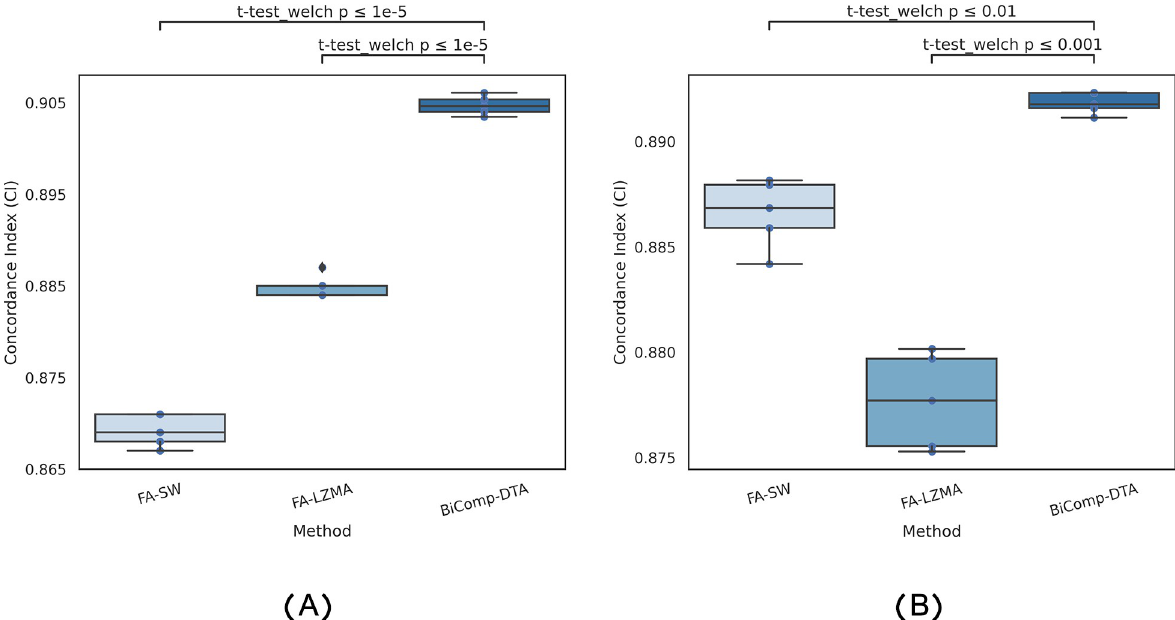
Fig 6. Full distribution of CI values and the statistical test for the BiComp-DTA, compared to the feature ablation SW and lzma- experiments on (A) Davis and (B) Kiba datasets. https://doi.org/10.1371/journal.pcbi.1011036.g006 sequences and extra CNN block for learning the protein representations. FusionDTA employs ESM-1b transformer [25] along with a fully-connected and a BiLSTM network for distributed protein encoding and feature extraction from the protein. The execution times for training and inference phases are reported in Table 11 for both GPUs and CPUs platforms, in terms of the seconds/epoch. According to this table, all three versions of BiComp-DTA provided smaller training and inference times, compared to the DeepDTA, WideDTA, and FusionDTA, for two benchmark datasets on GPUs and CPUs. BiComp-DTA (128, 8) provided comparable training and inference time, compared to GraphDTA, while BiComp-DTA (32, 16) and BiComp-DTA (32, 8) provided smaller training and inference time, compare to GraphDTA. FC network provided the smallest training and inference time, except for training Kiba dataset on GPUs, at the cost of reduced accuracy. Therefore, BiComp-DTA can be adopted for the massive-scale datasets with large numbers of protein and drug sequences. Furthermore, it can